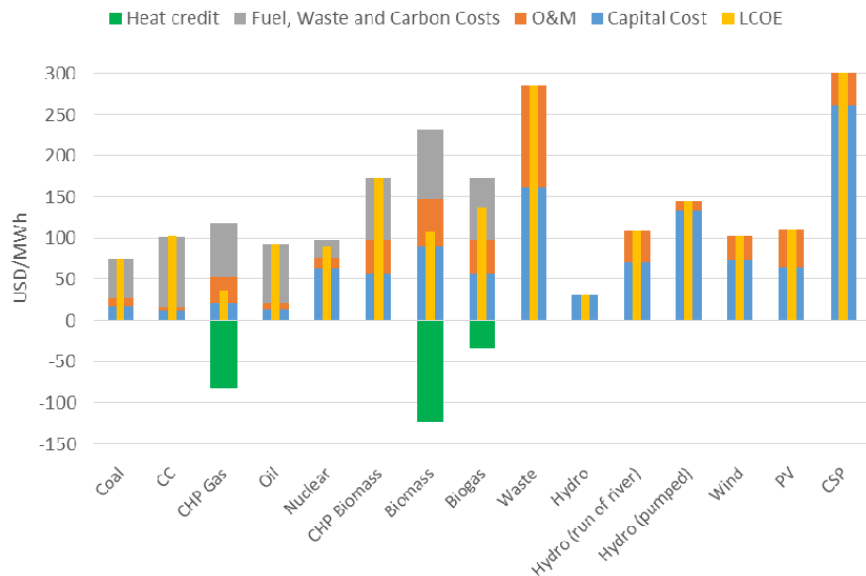
Figure 6. Economic performance of different technologies for power generation, as applicable to Spain in 2015 in terms of LCOE (adapted from [20]).